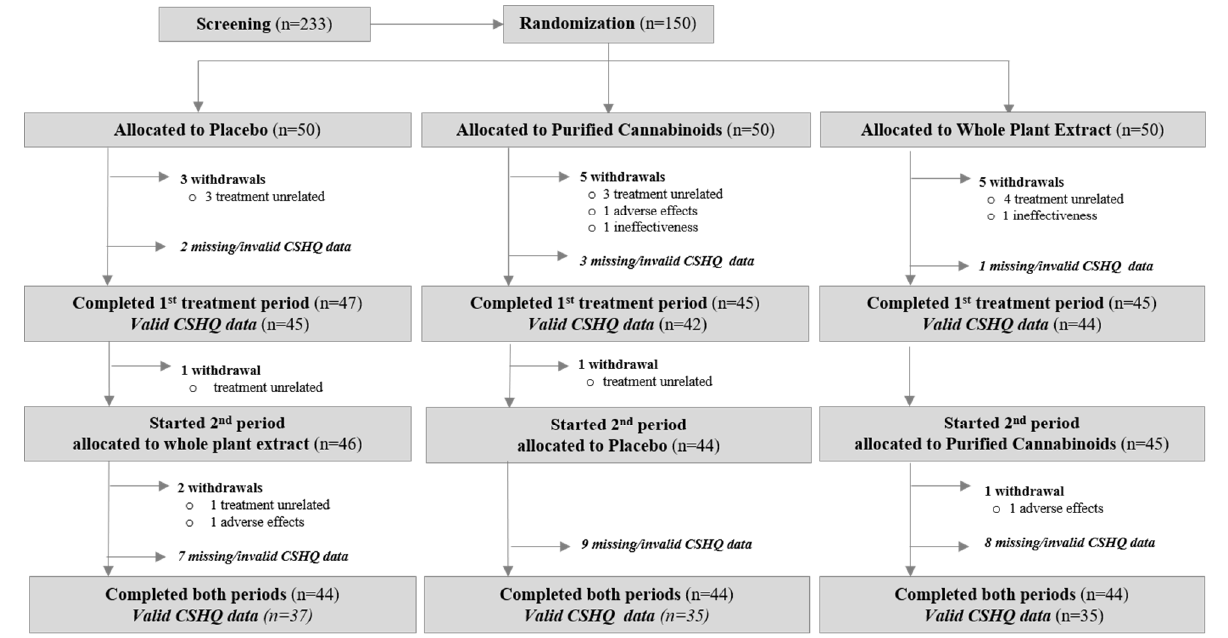
Figure 2. Participants’ allocation and adherence.